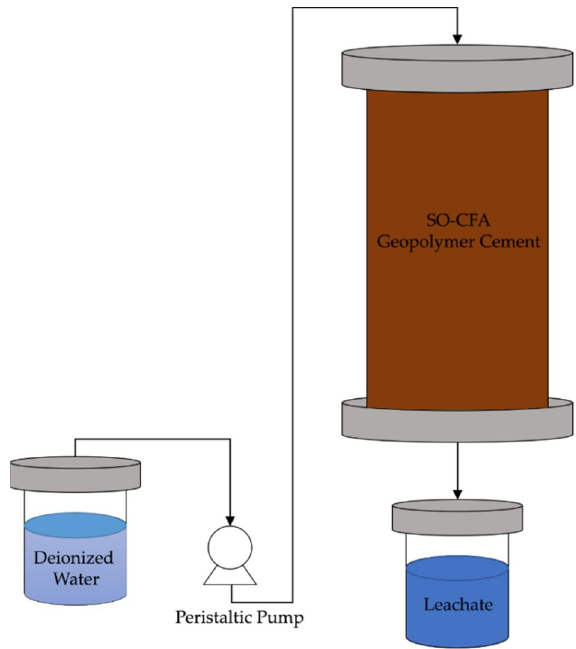
Figure 1. Schematic diagram of the modified column leaching test set-up.